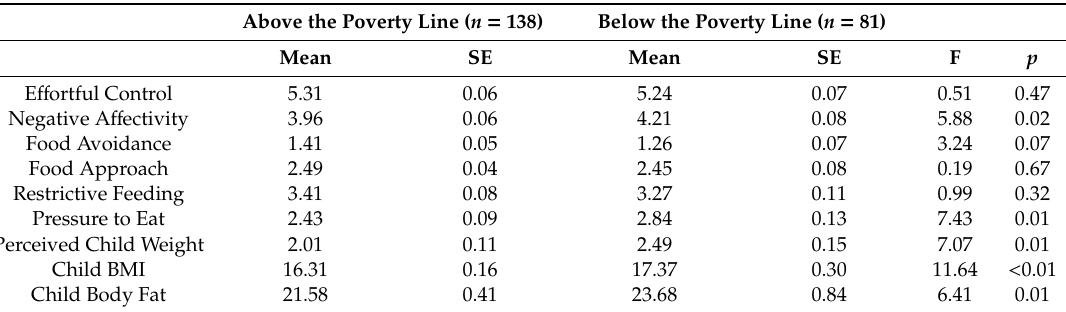
Table 3. Poverty status di ff erences for all the variables.